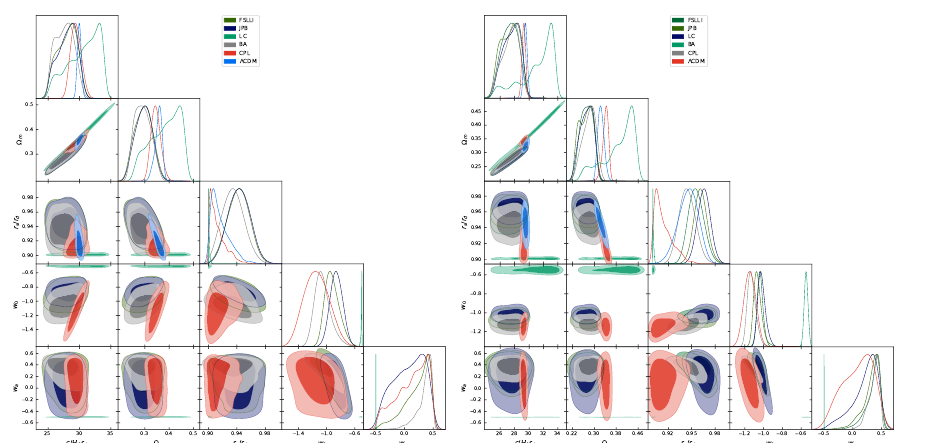
Figure A2. The posterior distribution for c / ( H 0 r d ) , Ω m , r ∗ / r d and w 0 , w a for different parametriza- tion of DE for the BAO+CMB dataset to the left and for the BAO+CMB+SN+GRB to the